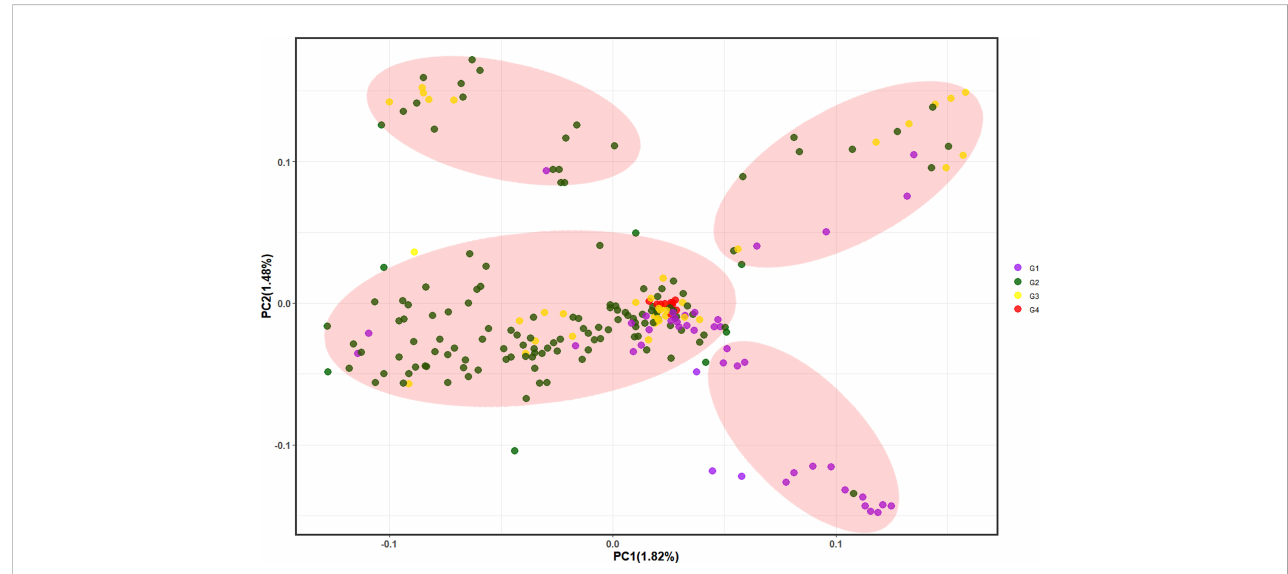
FIGURE 4 Principal component analysis where PC1 and PC2 represent the fi rst and second principal components, respectively. G1~G4 represent the 1 st , 2 nd , 3 rd and 4 th generation breeding parents,